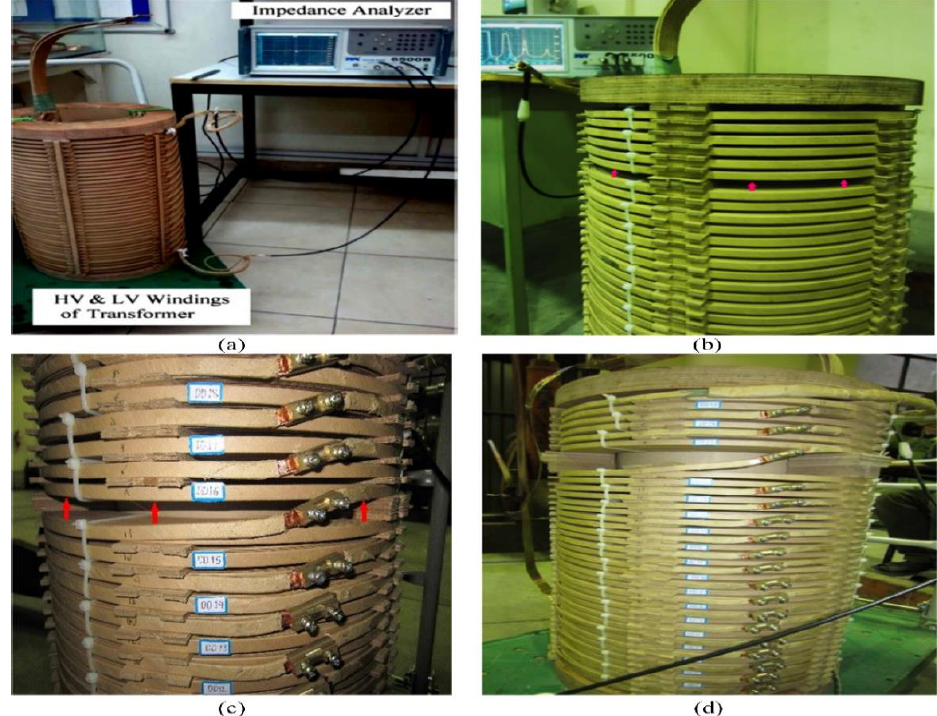
Figure 1. Experimental setup, ( a ) DPT windings and impedance analyzer; ( b ) low severity of DSV deformation; ( c ) average severity of DSV deformation; and ( d ) high severity DSV deformation .